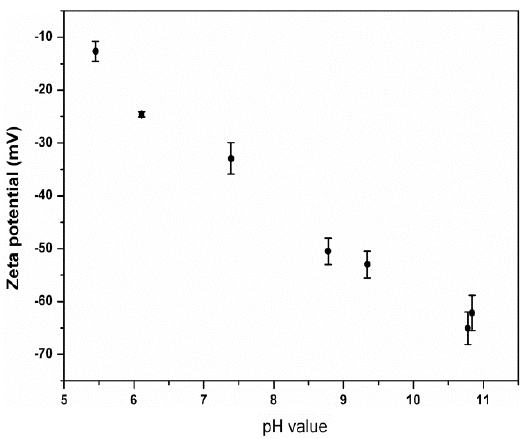
PO /Ag composites 3 4